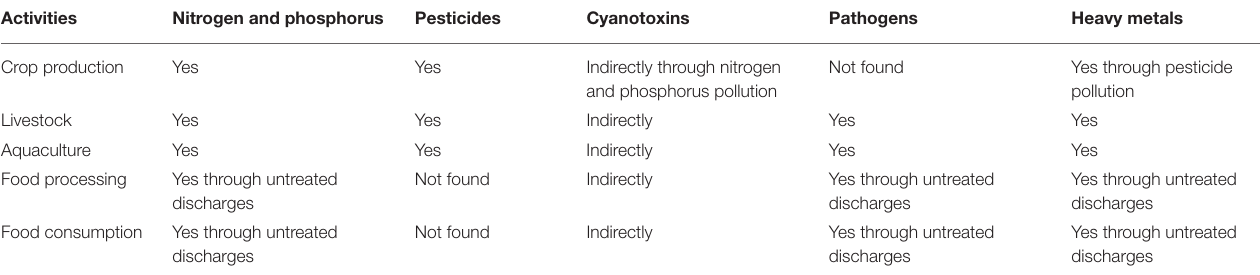
TABLE 6 | Impacts of food system activities to pollution of water